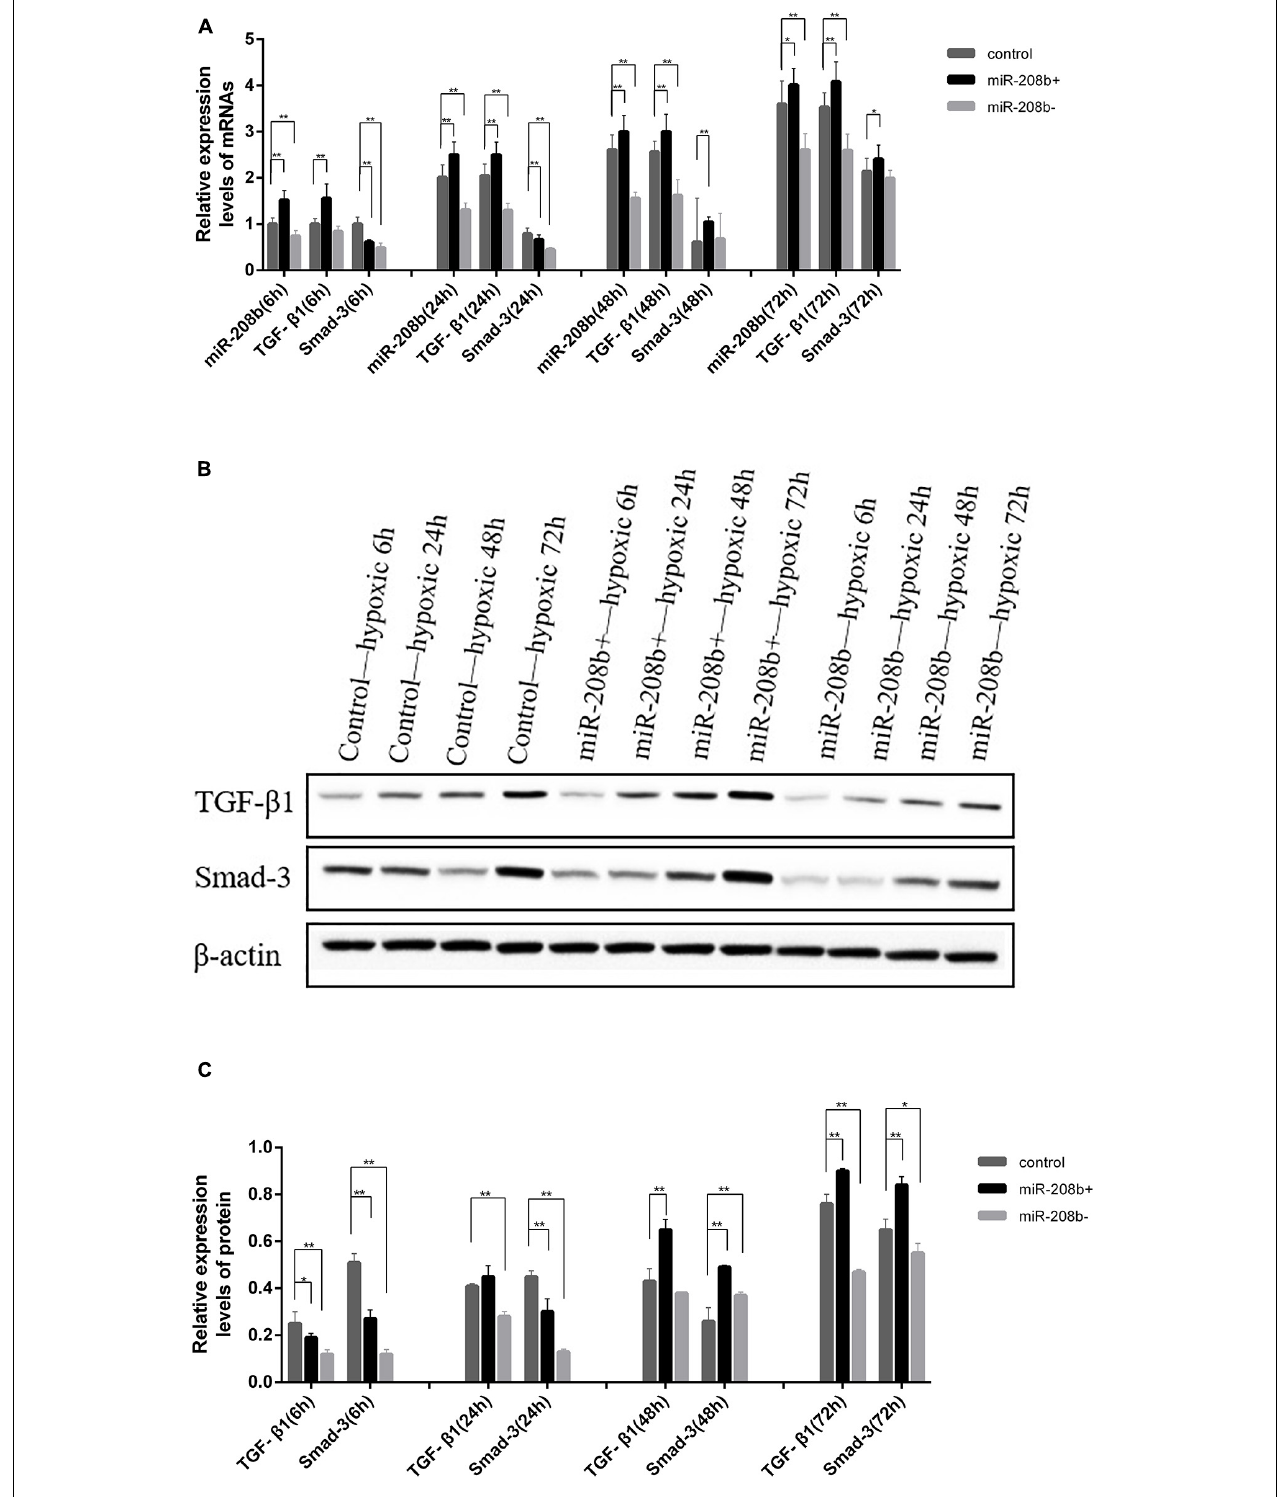
FIGURE 4 | Comparison of the expression of TGF- β 1 and Smad-3 in H9C2 cells following transfection with miR-208b mimics and miR-208b inhibitors. (A) Comparison of the expression of TGF- β 1, Smad-3, and miR-208b detected by RT-qPCR in each group; (B) Representative blot images; (C) Comparison of the expression of TGF- β 1 and Smad-3 detected by western blot analysis in each group. miR-208b +, miR-208b overexpression group; miR- 208b-, miR-208b inhibition group; TGF- β 1, transforming growth factor- β 1; * P < 0.05 compared with the blank group; ** P < 0.01 compared with the blank group.